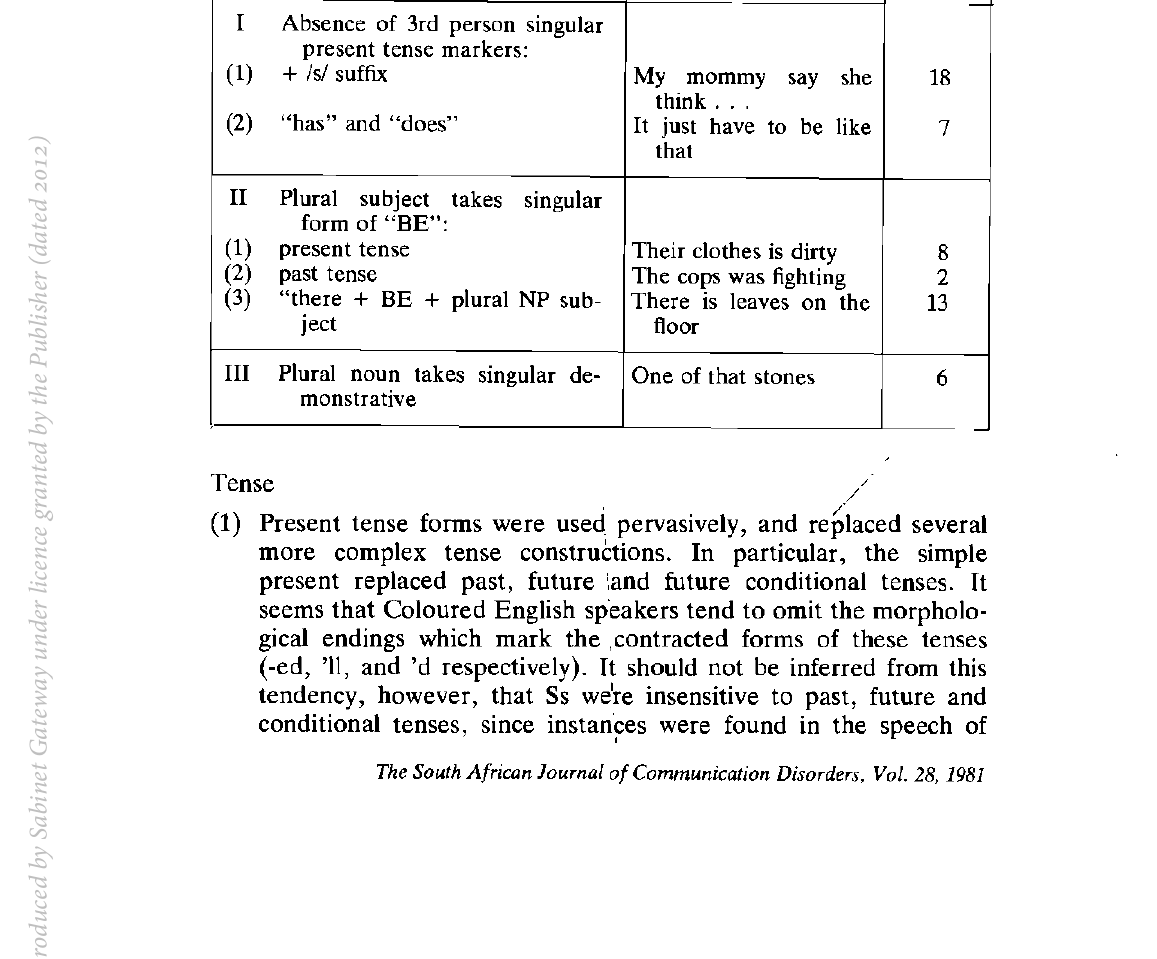
TABLE II: Non-standard number-verb agreement in Coloured